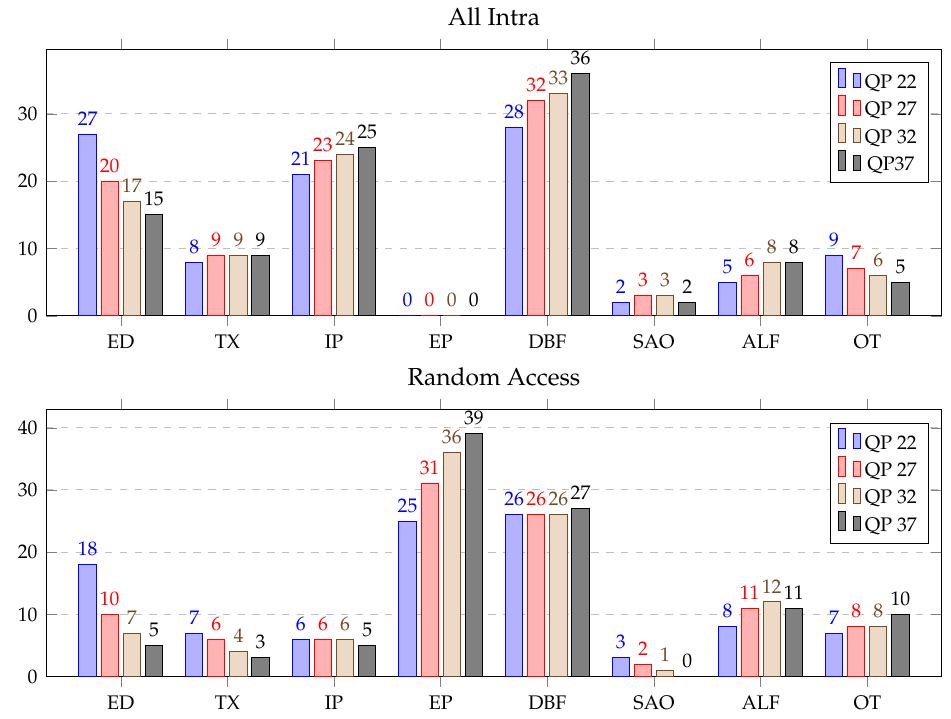
Figure 5. Average time distribution for different blocks of the VVC decoder (in %) over the HGPP.